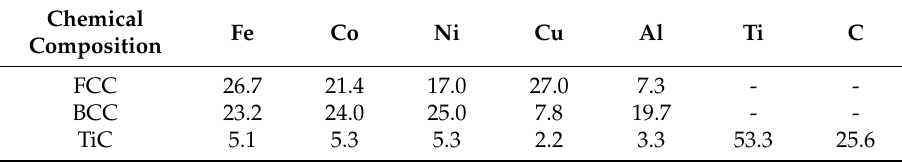
Table 2. Chemical compositions of the FCC phase, BCC phase, and TiC